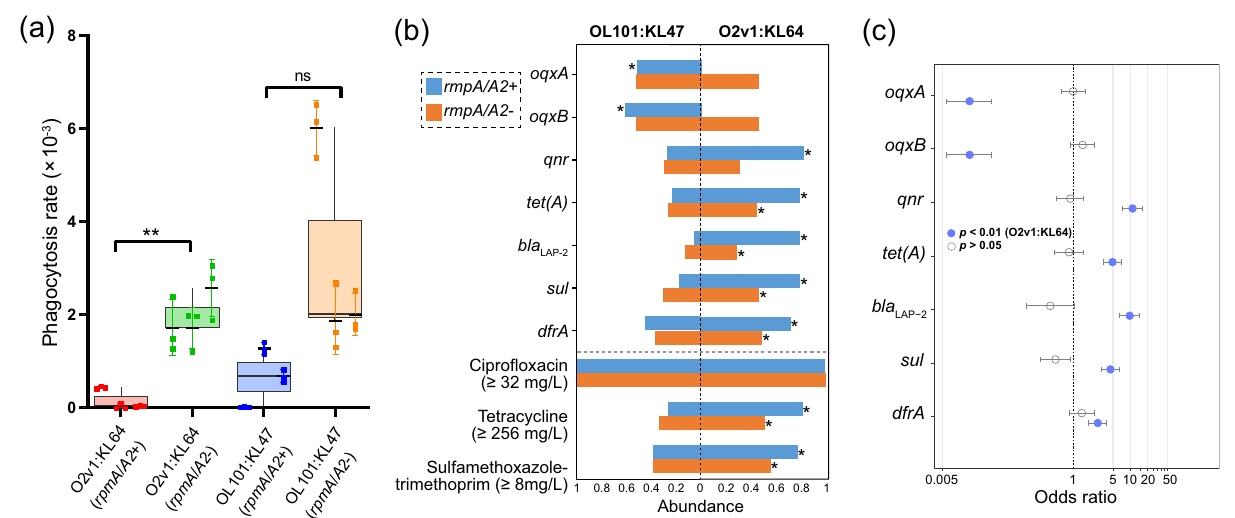
Fig. 5 | Phenotypes and genotypes with signi fi cant differences between OL101:KL47andO2v1:KL64.a Comparisonofphagocytosisresistanceforisolates w/ovirulenceplasmids(indicatedbythepresenceof rmpA/A2 ).Threeisolateswere randomly selected for each group in the test, i.e., O2v1:KL64- rmpA/A2 +(KP33367, KP47434, and KP66639), O2v1:KL64- rmpA/A2 - (KP33316, KP37485, and KP39199), OL101:KL47- rmpA/A2 +(KP16932, KP41051, and 46882), and OL101:KL47- rmpA/A2 - (KP30412, KP43350, and KP73269). The assay was triplicated, and the error bars represent standard deviations. Student ’ s t -tests were used for pairwise group comparisons, and rmpA/A2 -positive O2v1:KL64 isolates showed signi fi cantly enhanced resistance to phagocytosis than rmpA/A2 -negative O2v1:KL64 isolates ( p =0.0043).Boxplots are displayedusing the Tukey method (center line, median; boxlimits,upperandlowerquartiles;whiskers,lastpointwithina1.5xinterquartile